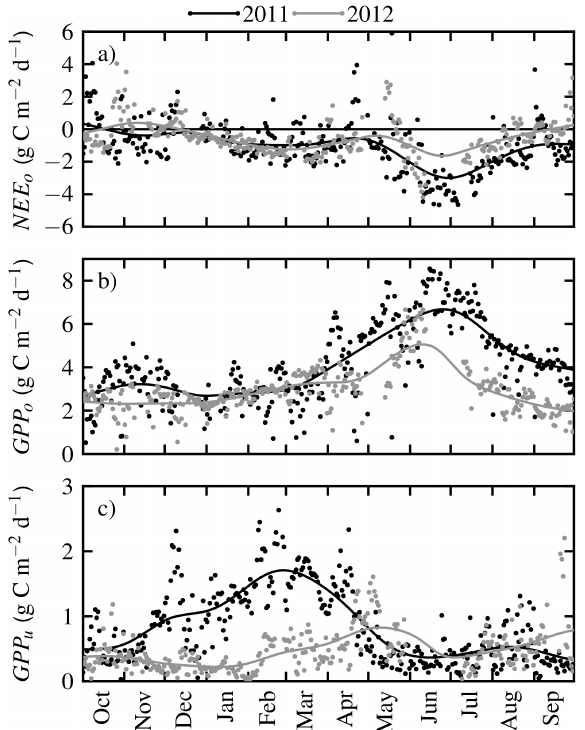
Figure 6. (a) Ecosystem net carbon exchange NEE o , (b) ecosys- tem gross primary productivity GPP o , (c) understorey gross primary productivity GPP u for 2011 (black) and 2012 (grey). Dots mark daily sums, and lines are kernel